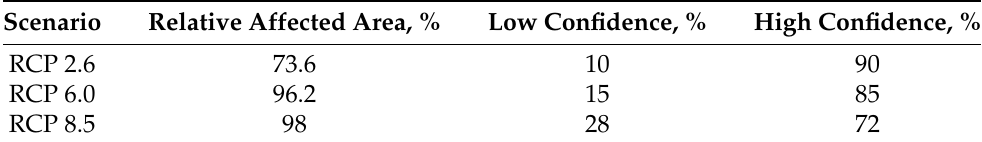
Table 4. Relative affected area and classifiers’